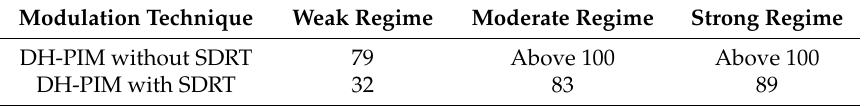
Table 4. SNR values (in dB) for DH-PIM with SDRT and without SDRT at BER 10 − 8 for weak, moderate and strong